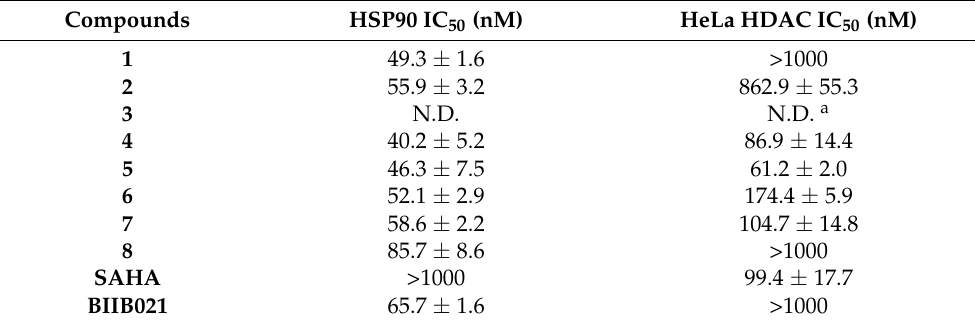
Table 1. Inhibition of HeLa nuclear extract HDAC activity and HSP90 chaperone protein by com- pounds 1 – 8 .